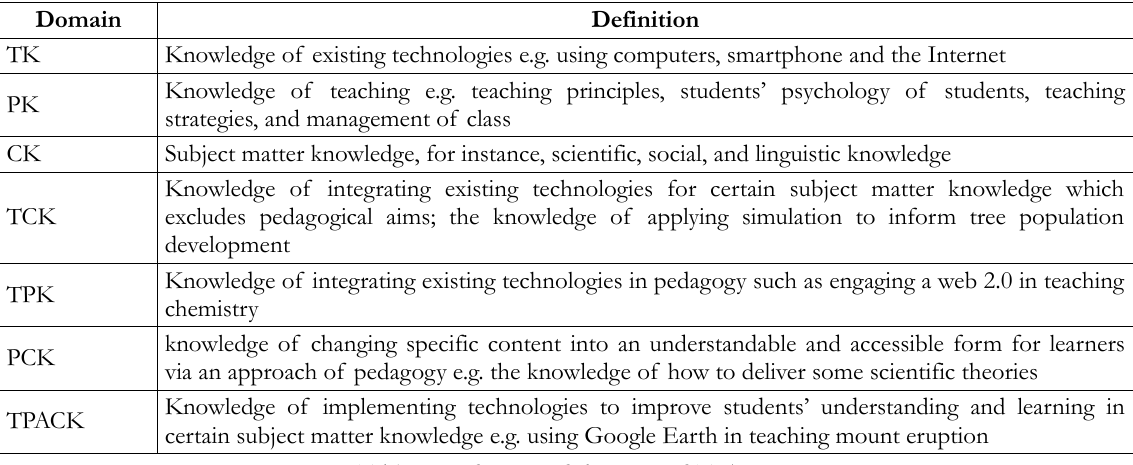
Table 1. Definition of domains of